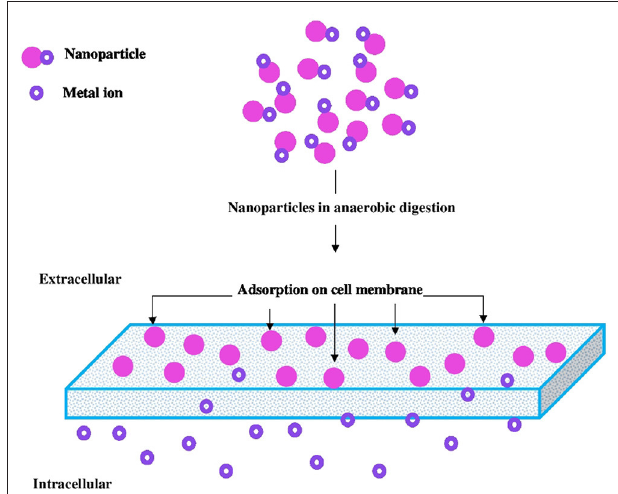
FIGURE 3 | Mechanism of nanoparticle addition in anaerobic